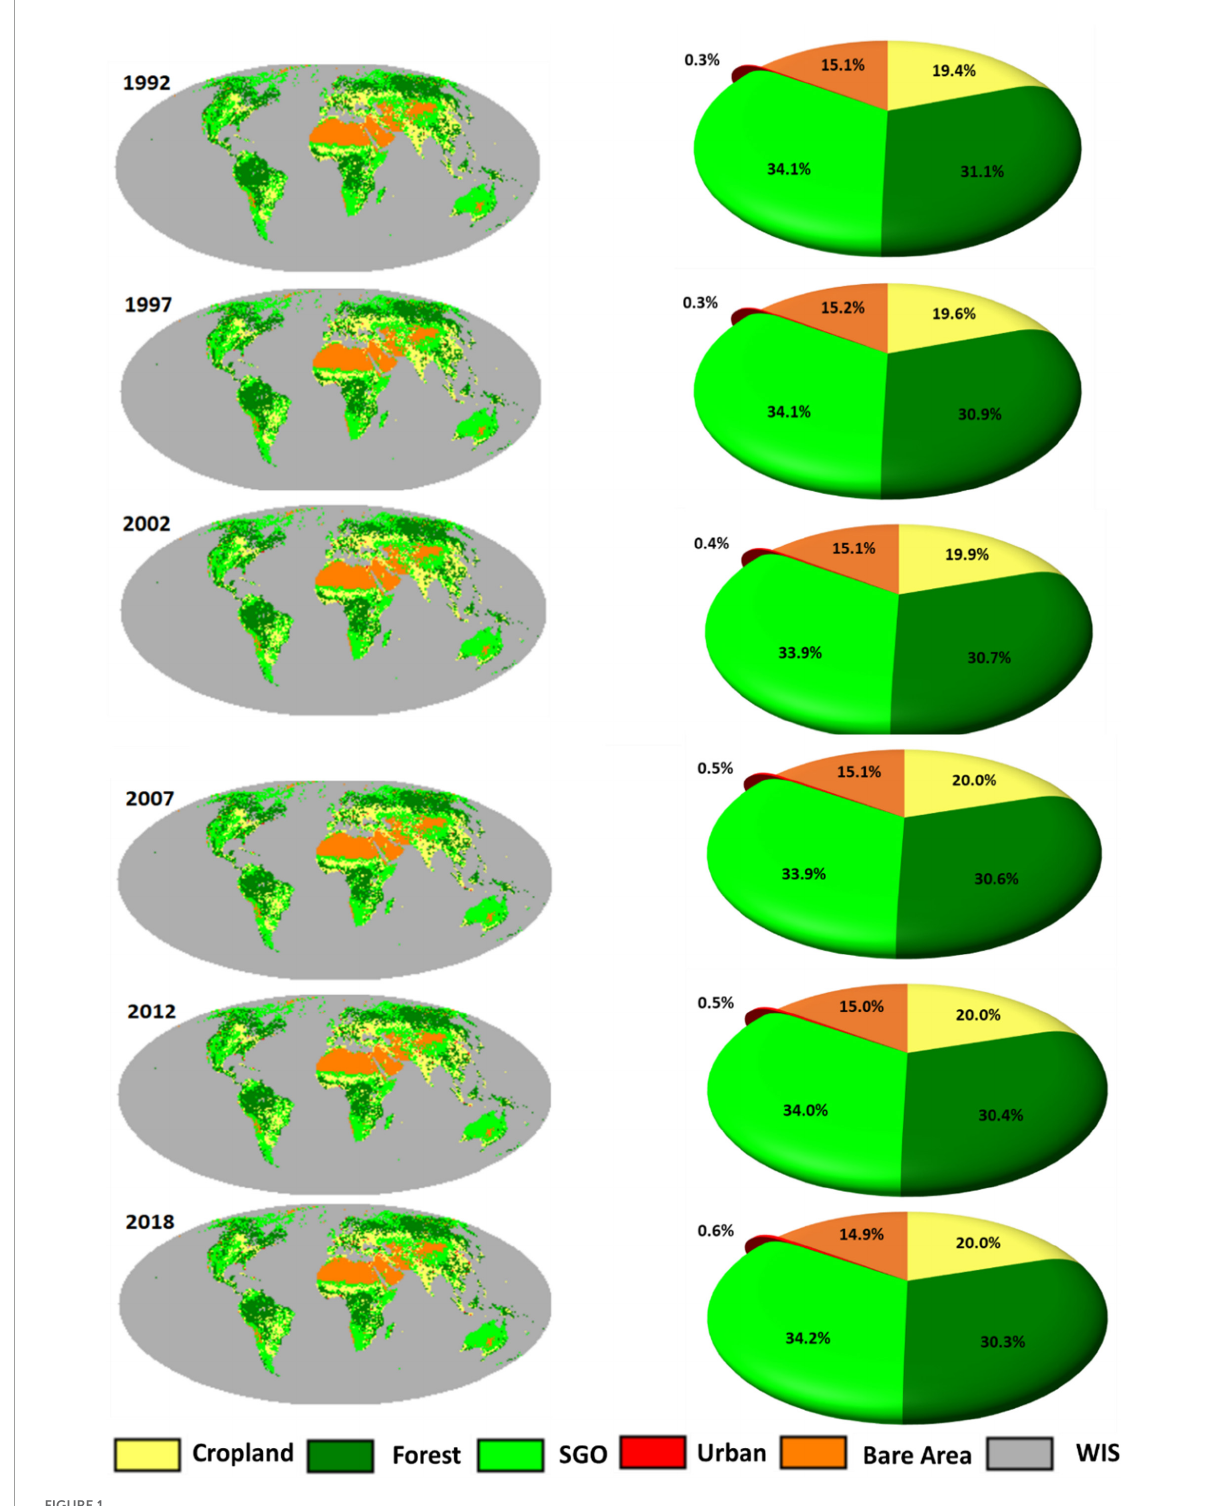
FIGURE1 Spatial distribution of land-cover classes on maps for 1992, 1997, 2002, 2007, 2012, and 2018 (left) and the corresponding pie charts showing the breakdown percentage of each category (right) .